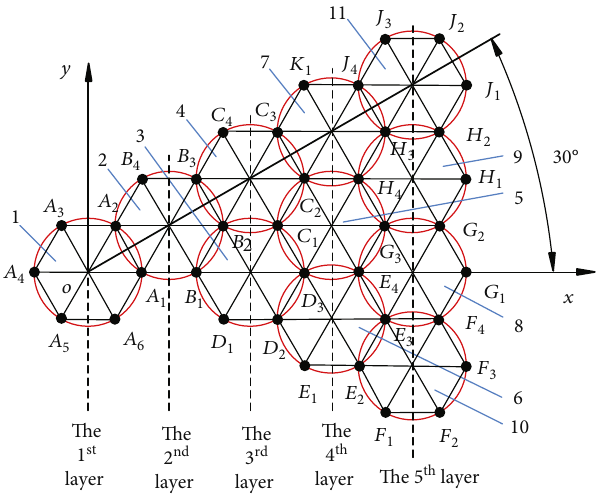
Figure 11: Typical envelope